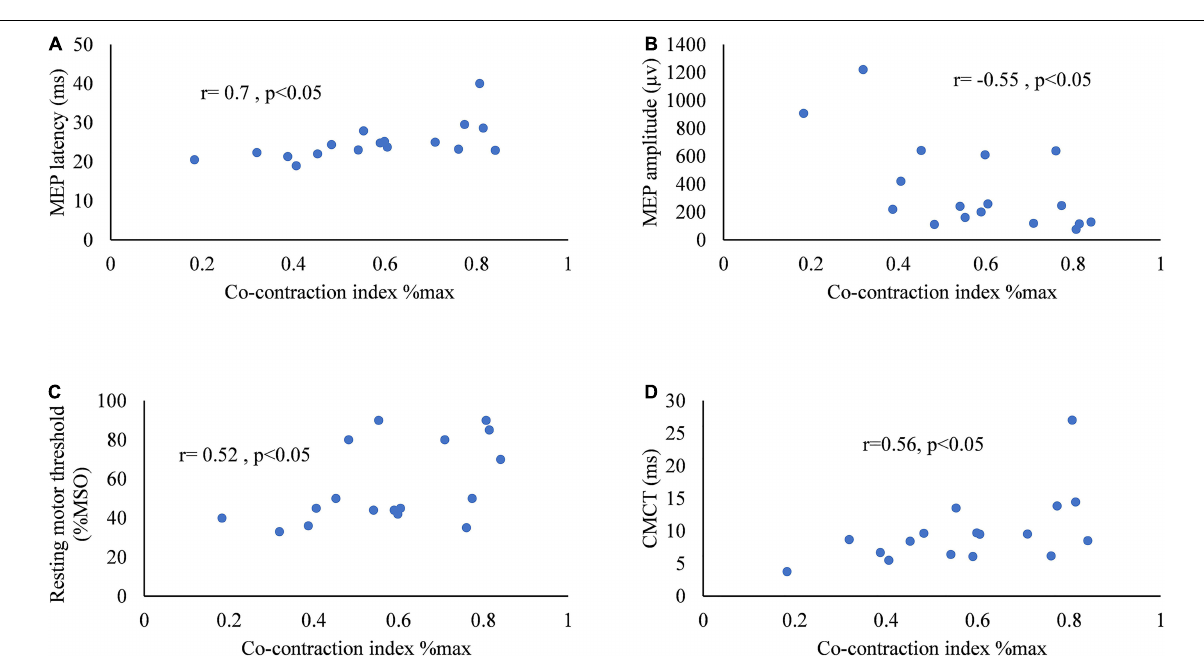
FIGURE 5 | Scatter diagrams of the co-contraction index of flexor digitorum and extensor digitorum during horizontal task versus (A) MEP latency, (B) amplitude of MEP, (C) resting motor threshold of MEP, and (D) central motor conduction time of MEP.